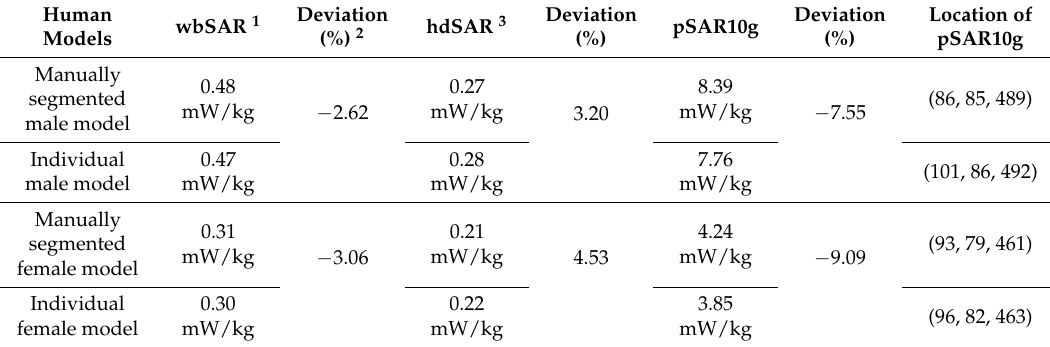
Table 4. Deterministic simulation results for the models at the standard position in the coil.